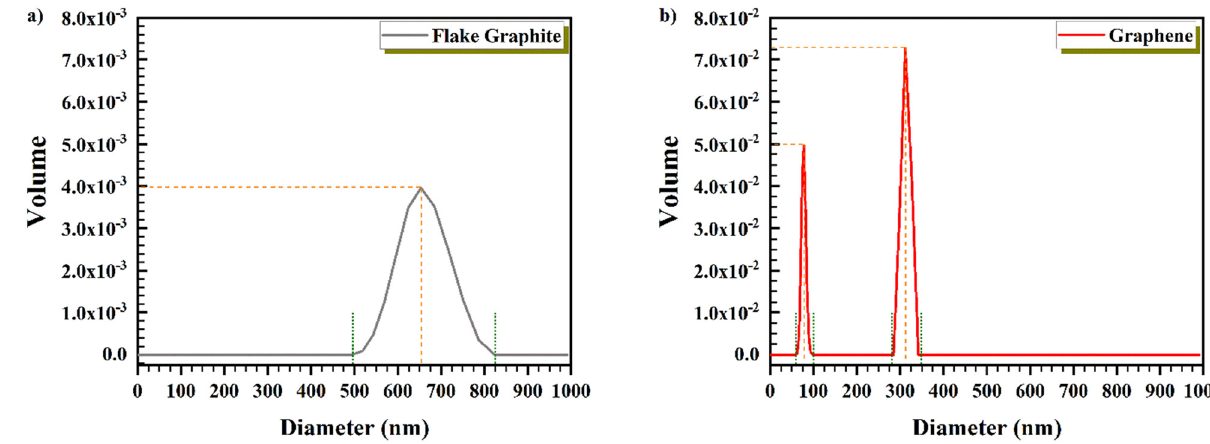
Figure 4: DLS of ( a ) fl ake graphite and ( b )